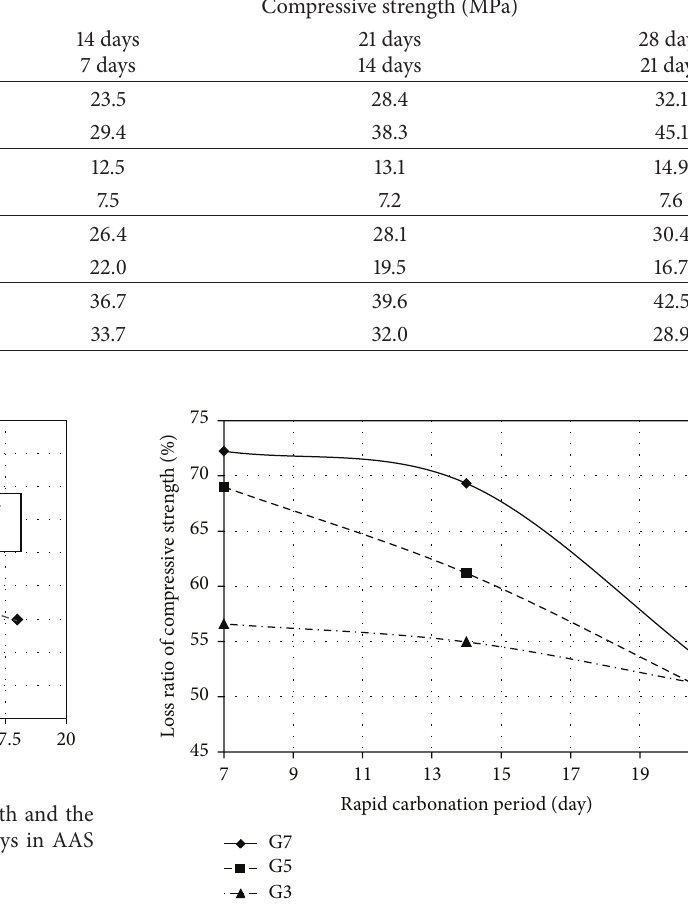
Figure 6: Compressive strength loss of the carbonation product in the AAS